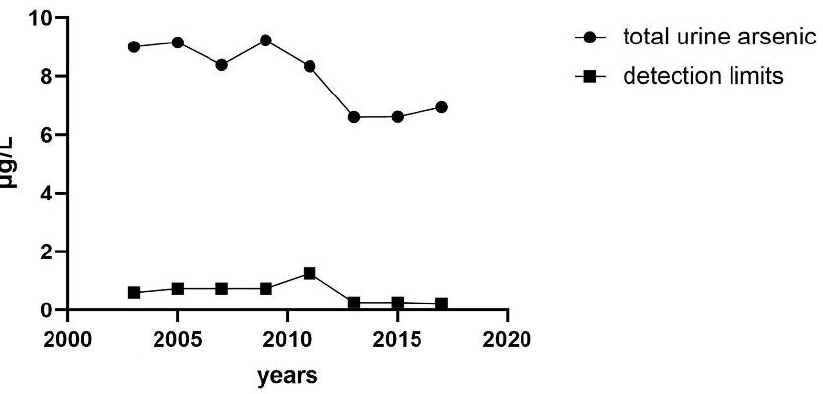
Figure 2. Median concentration of total urinary arsenic varies with years.